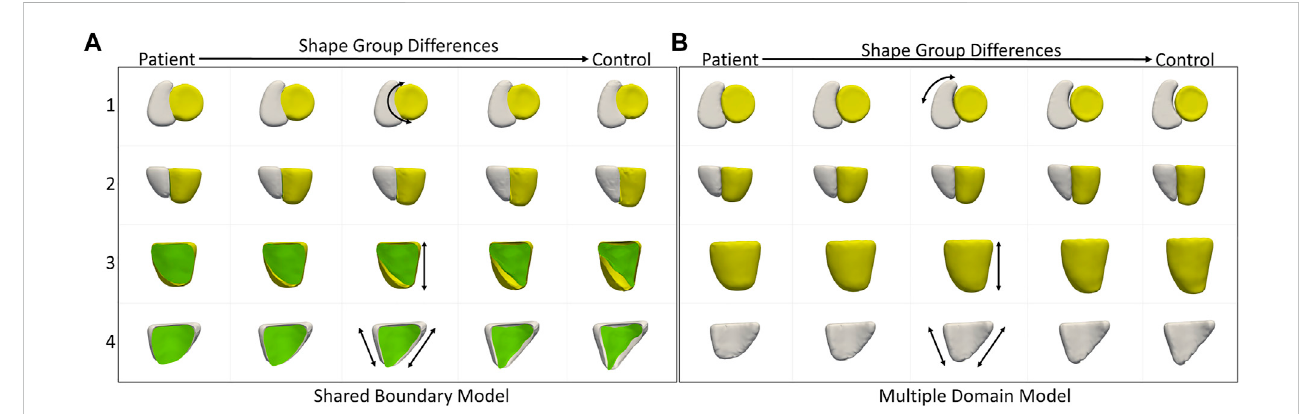
FIGURE 6 Group shape differences identi fi ed by (A) the proposed shared boundary and (B) the multiple domains model. Each row shows the samples from a different view to visualize the differences. The black arrows indicate the direction of the variation of